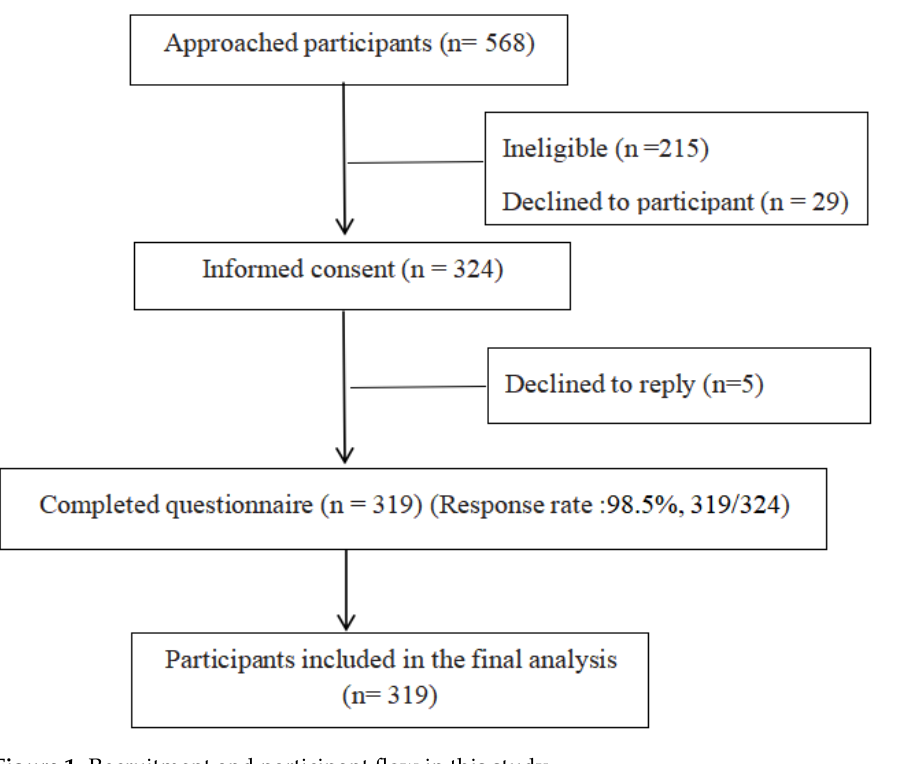
Figure 1. Recruitment and participant flow in this study.